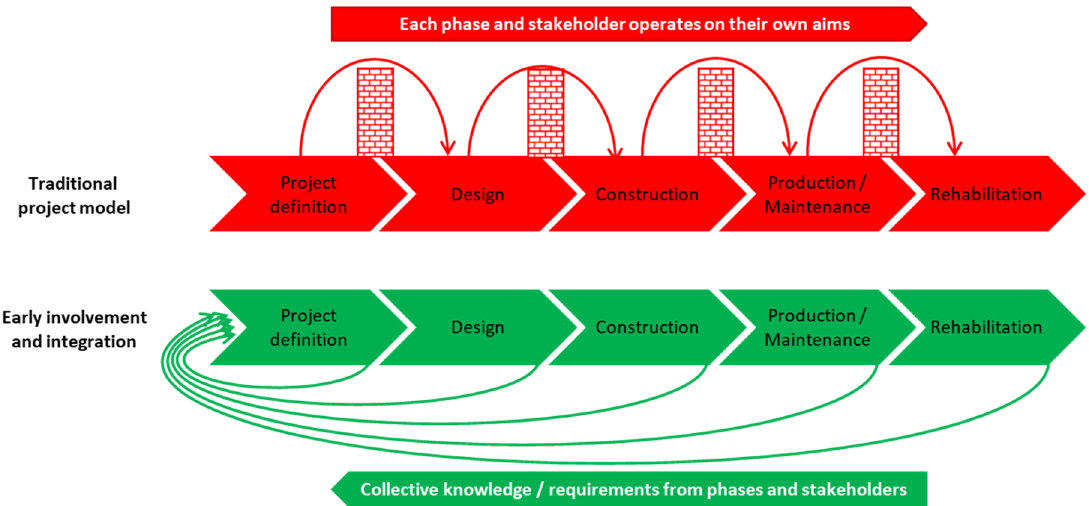
Figure 4. Ideological differences between traditional linear project delivery and collaborative project delivery implementing integration and early stakeholder involvement, modified from [28].